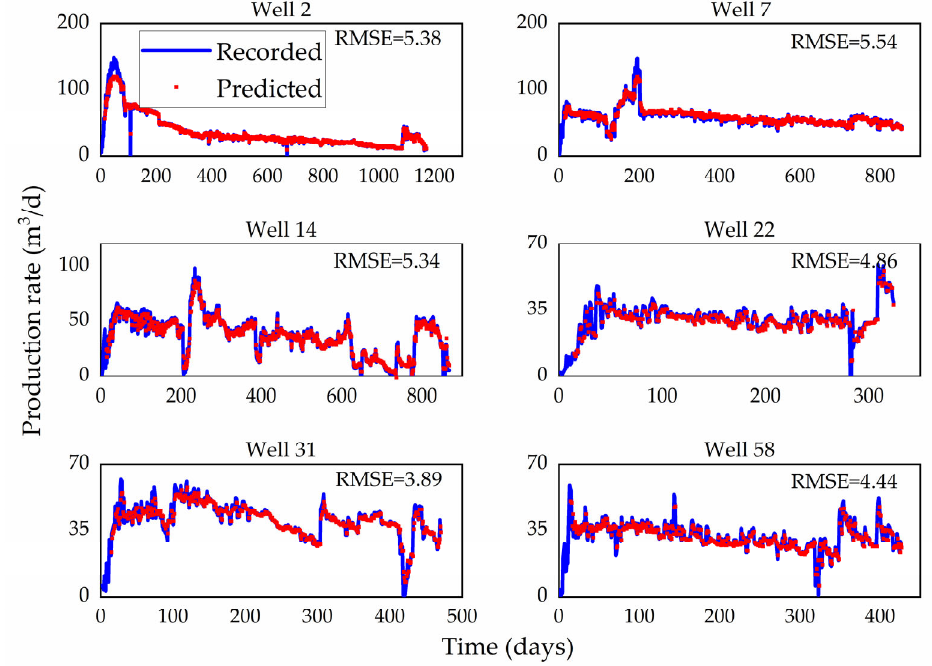
Figure 10. The predicted production of test wells with GRU and the SingleStep approach.